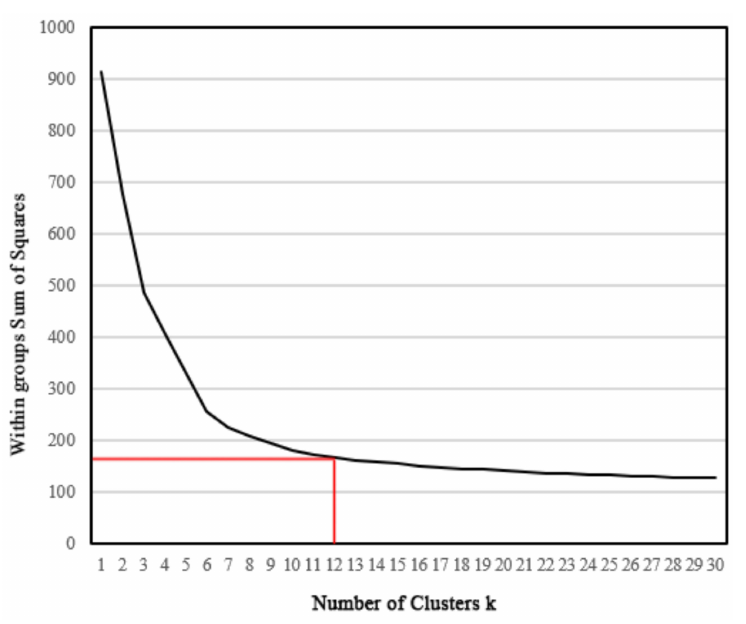
Figure 8. Comprehensive ecosystem service evaluation